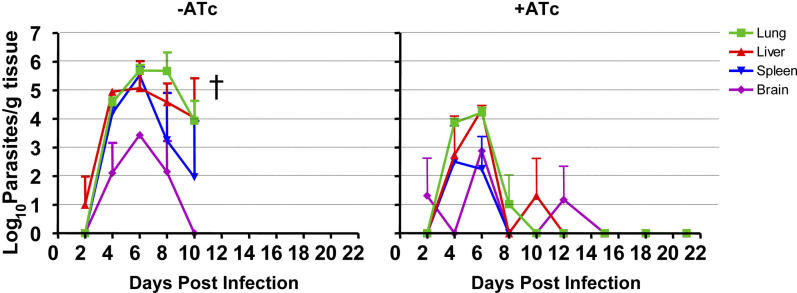
Δmic2e/mic2i + ATc Parasites Fail to Reach High Tissue Levels and Are ClearedParasite tissue burden of mice during infection with Δmic2e/mic2i treated with and without ATc. Organs from three mice were isolated at each time point and analyzed by rtqPCR using parasite specific primers. The normal time-till-death Δmic2e/mic2i without ATc is indicated by a “†.”